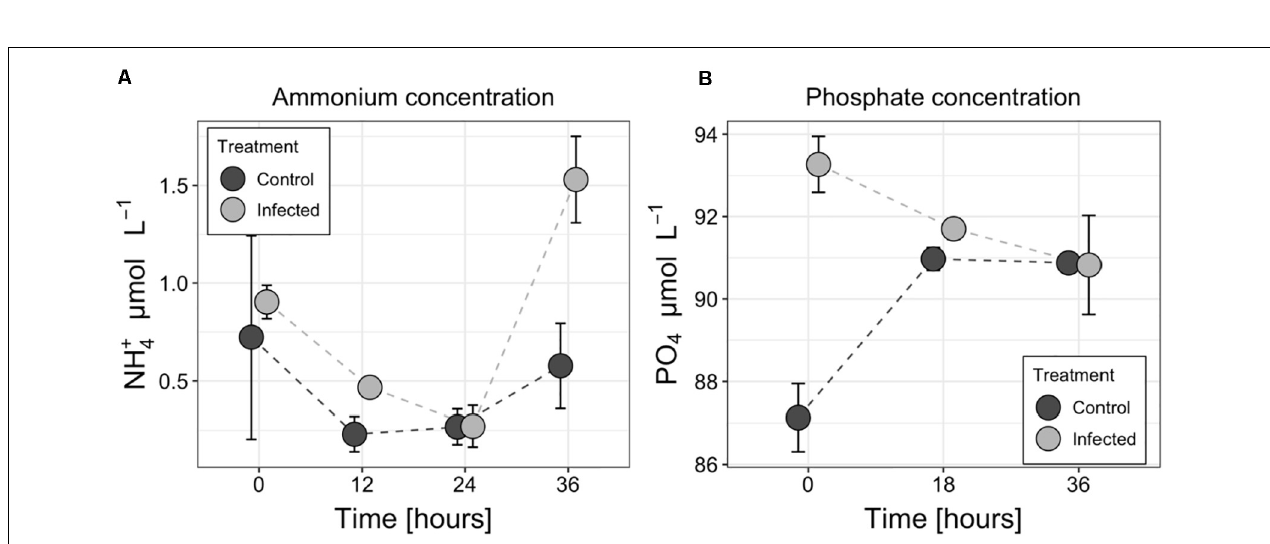
FIGURE 5 | Changes in ammonium (A) and phosphate (B) concentrations in the medium of the control and infected cultures of the Aphanizomenon flos-aquae strain 2012/KM1/D3. Symbols indicate the mean values, and the error bar shows the standard deviation of three technical replicates.